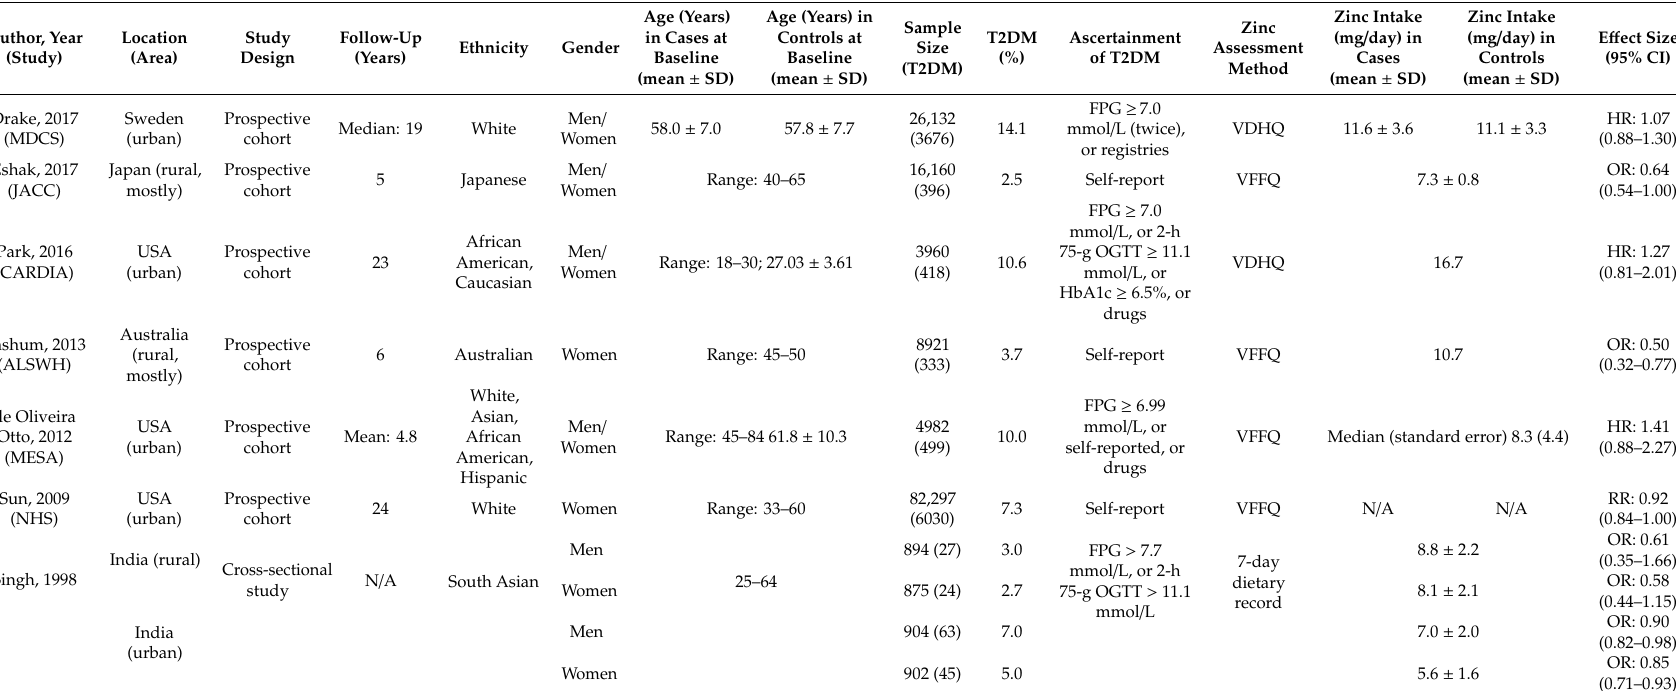
Table 1. Characteristics of studies reporting the association between dietary zinc intake and risk of type 2